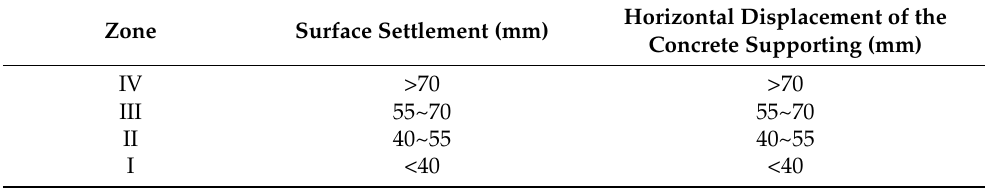
Table 6. Criteria of adjacent influential partition based on